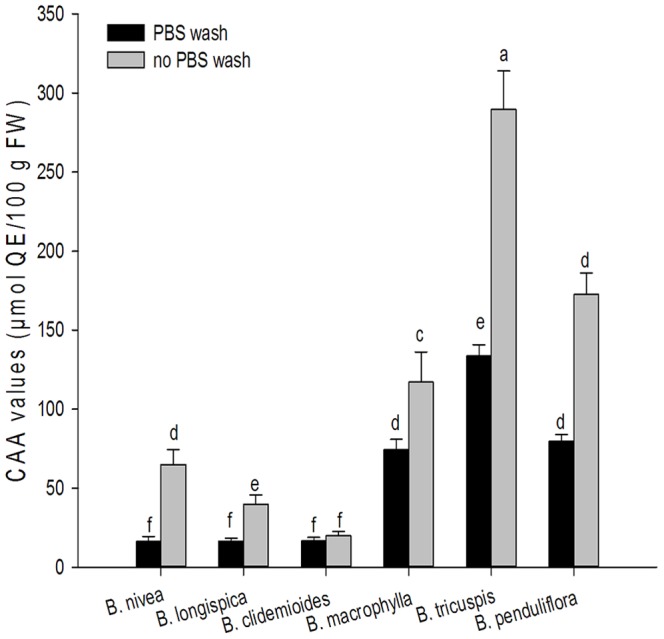
CAA values in six species of ramie leaves (mean ± SD, n = 3).Bars with no letters in common are significantly different (p<0.05).